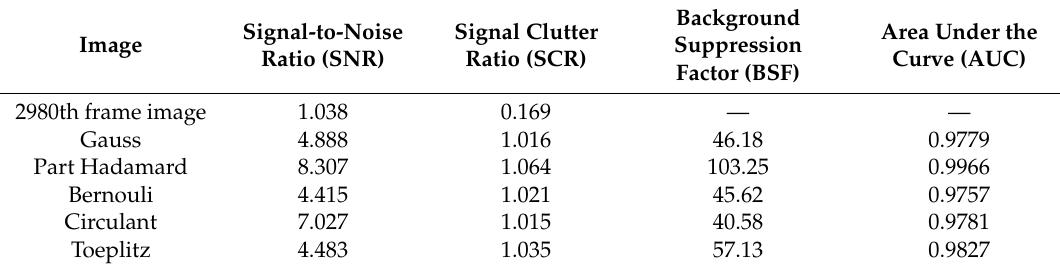
Table 2. Evaluation index of the subtraction image.